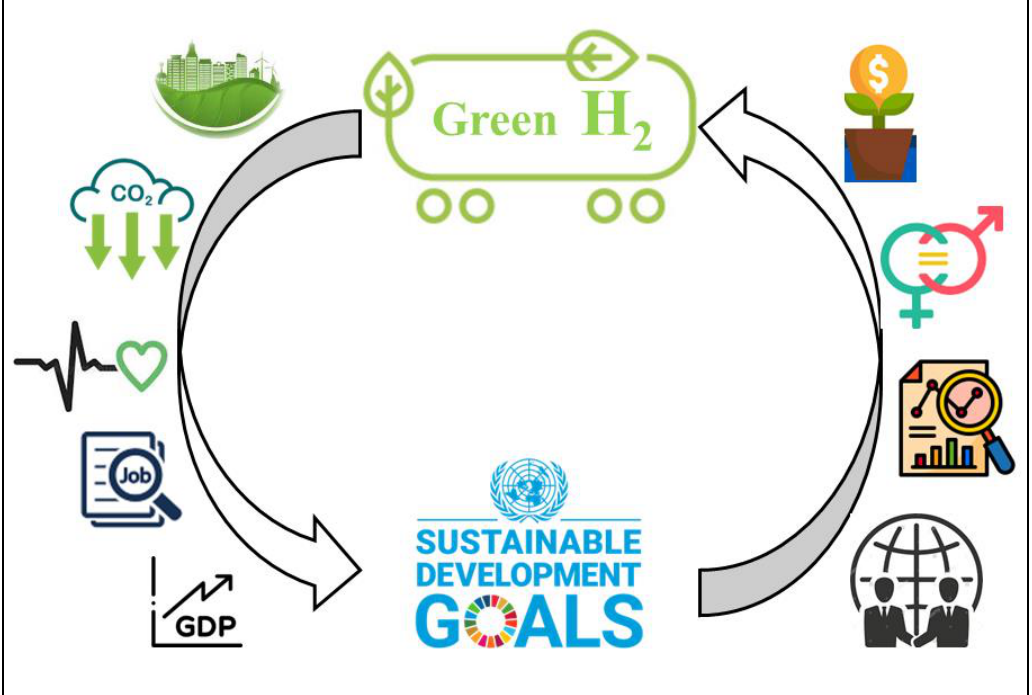
Figure 3 . Green Hydrogen use in compliance with SDGs . Figure 3. Green Hydrogen use in compliance with